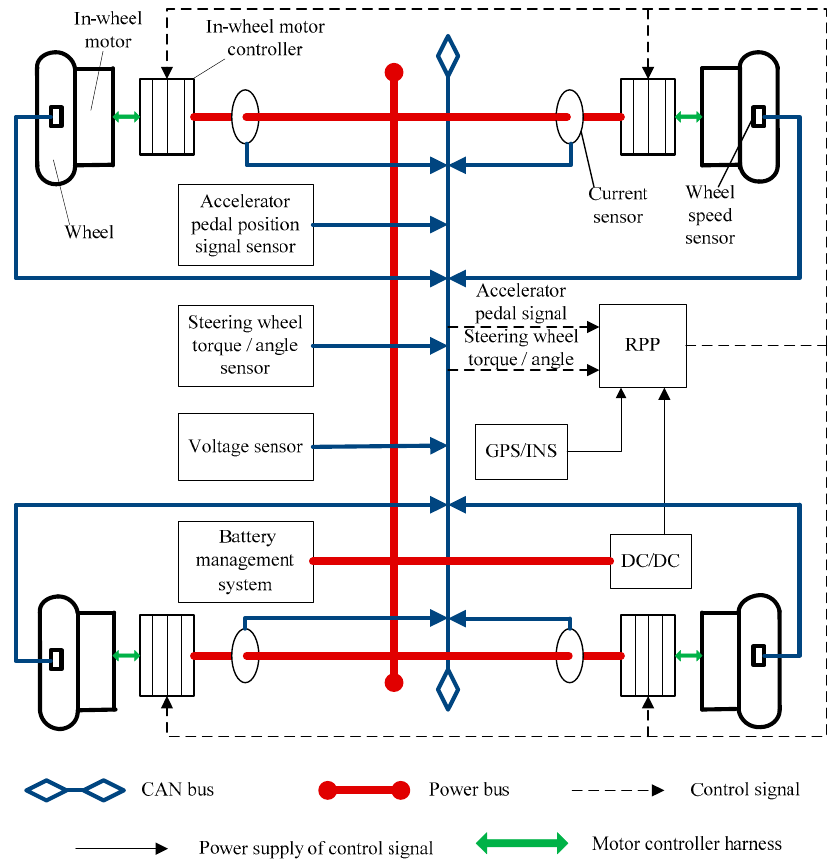
Figure 1. Driving architecture and control network framework of the electric vehicle.